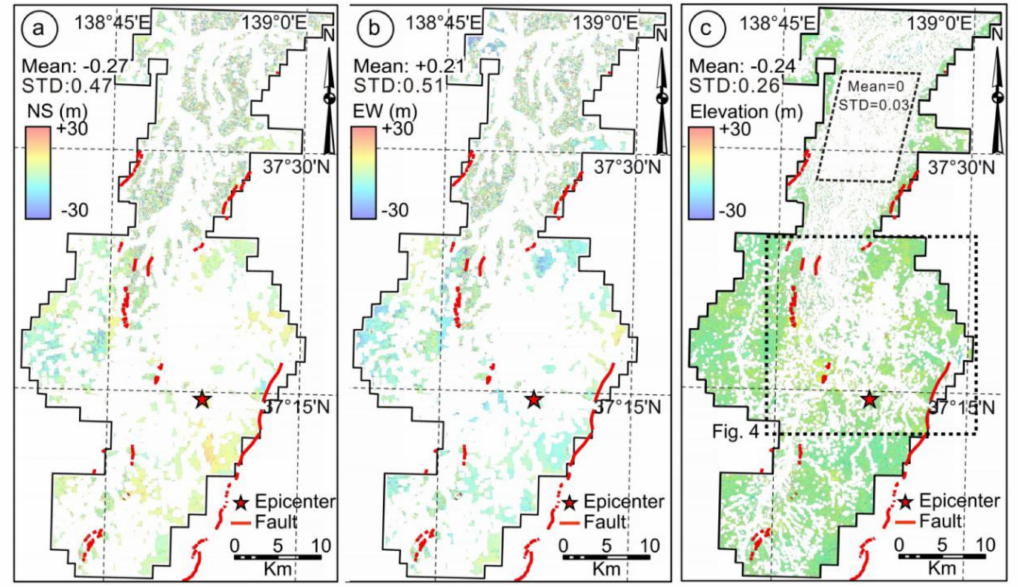
Figure 3. The horizontal differences between pre- and post-earthquake DEMs in the N-S direction ( a ), E-W direction ( b ), the elevation changes obtained by subtracting the pre-earthquake DEM from the post-earthquake DEM ( c ). The flat regions far from the epicentral area in the dashed parallelogram should show no obvious elevation change, which represents the accuracy of the differential DEM in this study. The dashed rectangle shows the location of Figure 4. The mean elevation change of the whole region is − 0.24 m with a standard deviation (STD) of 0.26 m. The white background indicates a value of zero. The colour scale is shown in